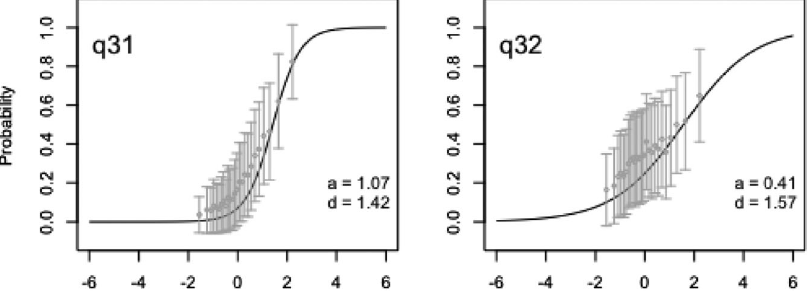
15. Item characteristic curves for the item 31 – 32 on the CSEM. The gray error bars represent one standard deviation, from top to bottom, in the student responses. The horizontal axis is student latent